Question: Express in one sentence what the figure is showing.
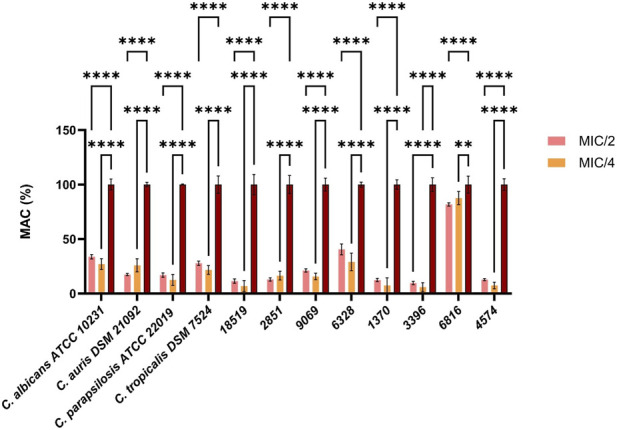
Answer: Microbial adherence percentage (MAC%) values for C. verum EO compared to the control Candida strains (** p < 0,01, **** p < 0,0001) (Dunnett’s multiple comparisons test).